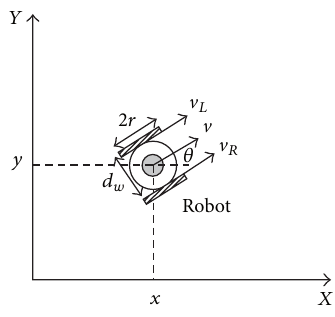
Figure 5: Path planning comparison of RIN and PC-AIN.